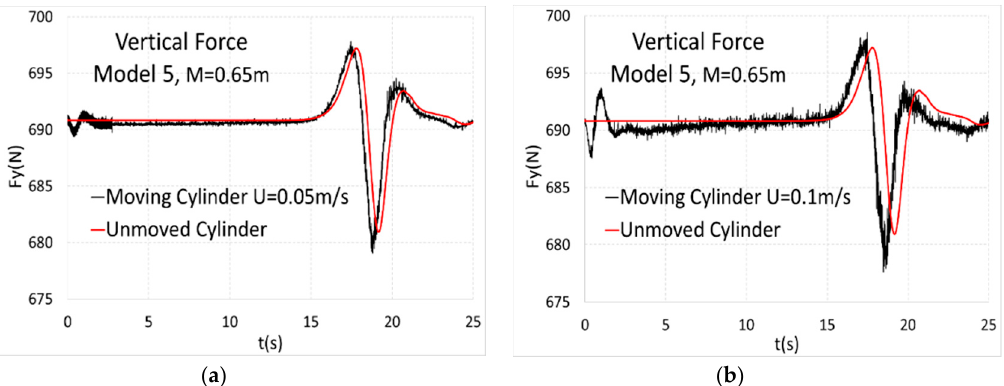
Figure 18. The time variation of vertical forces for model 5. ( a ) The comparison between the unmoved cylinder (red line) and the moving cylinder at U c = 0.05 m/s. ( b ) The comparison between the unmoved cylinder (red line) and the moving cylinder at U c = 0.1 m/s.